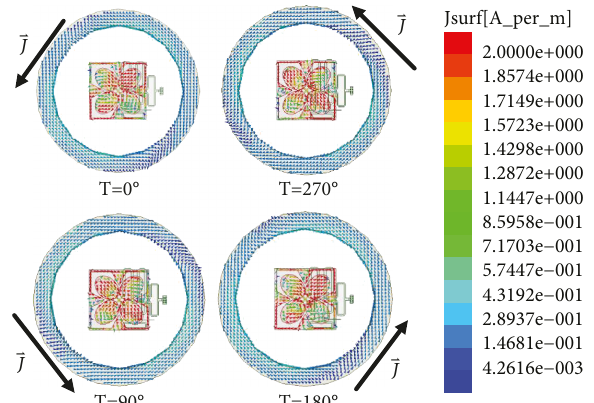
Figure 6: Current distribution at 1.4 GHz with time instant.